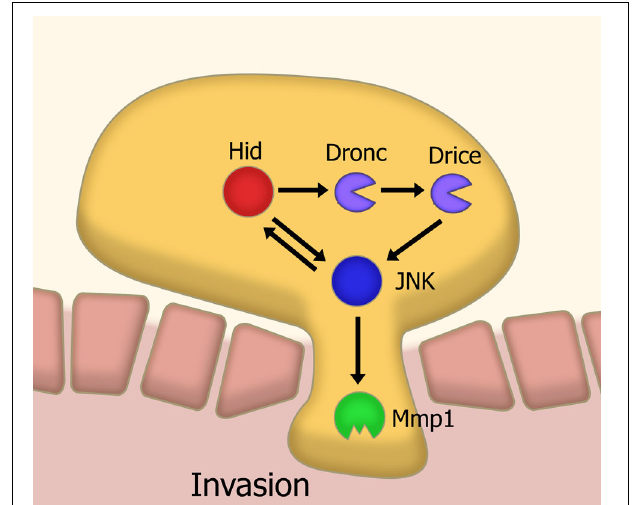
FIGURE 3 | Model of caspase-mediated tissue invasion based on Drosophila studies. A sub-apoptotic level of caspase activation leads to the activation, via JNK signaling, of matrix metalloproteases. This metalloprotease activity is a necessary step in the invasion of tissues. Abbreviations: JNK, Jun kinase; Mmp1, Matrix metalloprotease 1; Hid, head involution defective ; Dronc, Drosophila Nedd2-like caspase; Drice, Drosophila